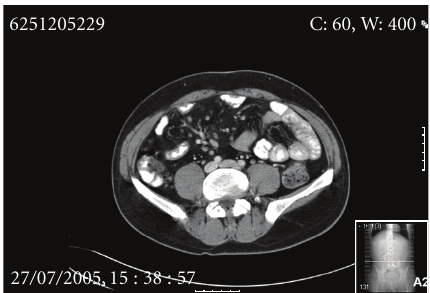
Figure 1: Thickening of terminal ileum and mesenteric lym- phadenopathy.